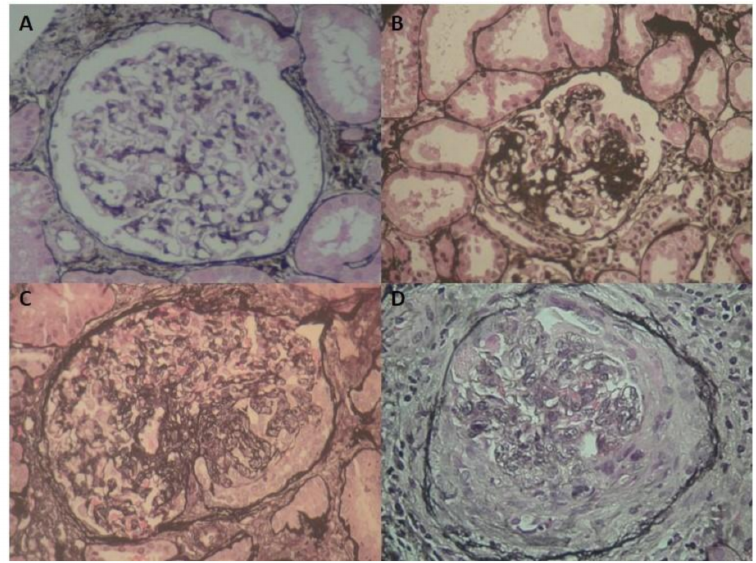
Figure 1. Histology of IgAN patients showing glomeruli with mesangial hyperplasia ( A ), focal seg- mental sclerosis ( B ), endocapillary and extracapillary hypercellularity ( C ), and cellular crescent ( D